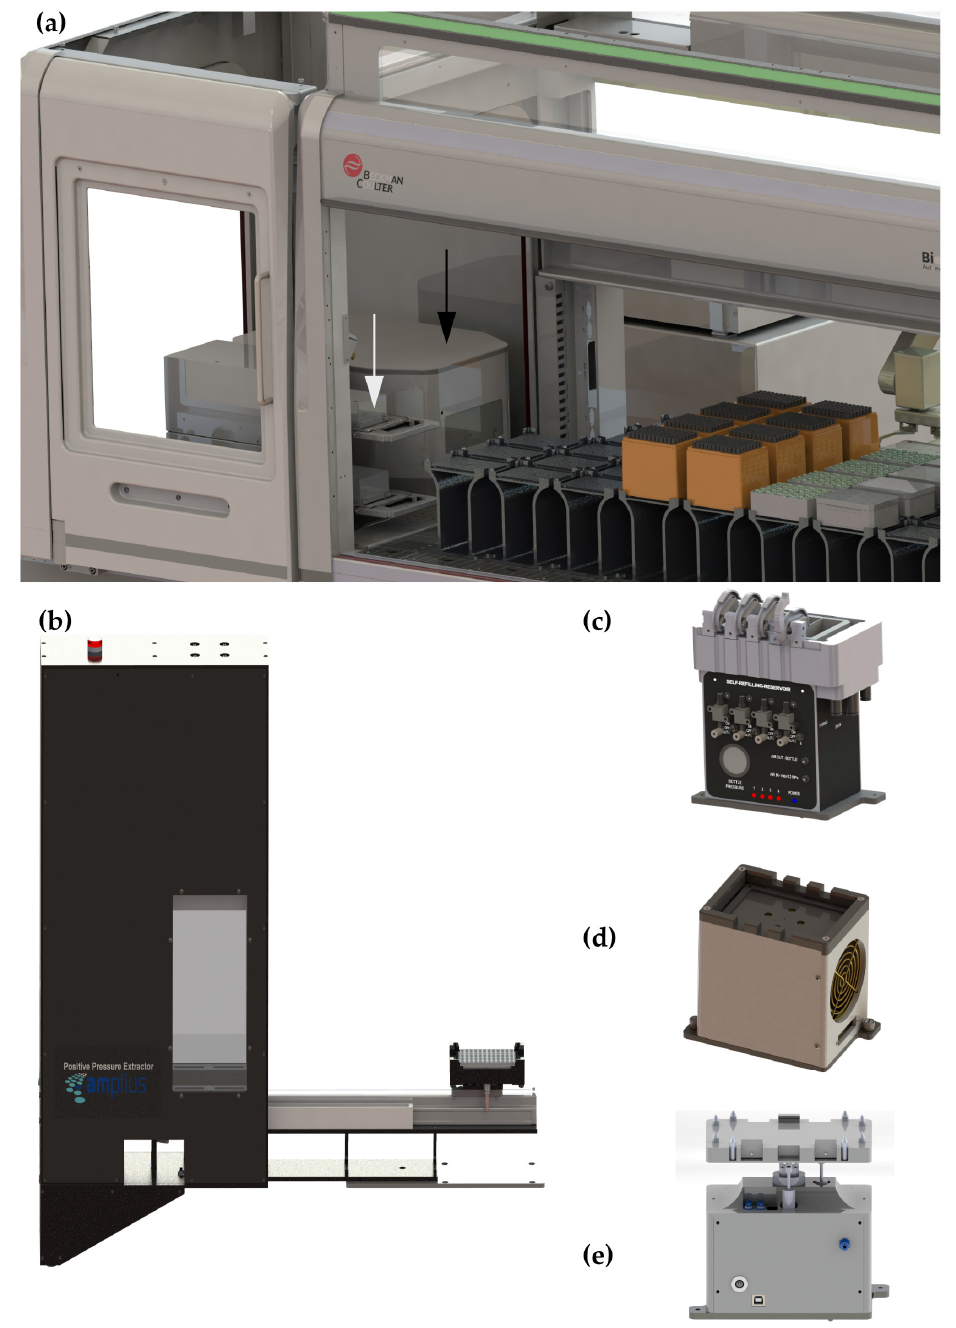
Figure 1. Integrated devices ( a ) Biomek i7 workstation (Beckman Coulter Life Sciences, Indianapolis, IN, USA) with incubator (in front, white arrow; INHECO Industrial Heating & Cooling GmbH, Martinsried, Germany) and centrifuge (back, black arrow; Agilent Technologies, Santa Clara, CA, USA) ( b ) Positive Pressure Unit V4 (amplius GmbH, Rostock, Germany) ( c ) Self Refilling Quarter Reservoir (amplius GmbH, Rostock, Germany) ( d ) Static Peltier ALP (INHECO Industrial Heating & Cooling GmbH, Martinsried, Germany) ( e ) 3D Tilting ALP (amplius GmbH, Rostock,